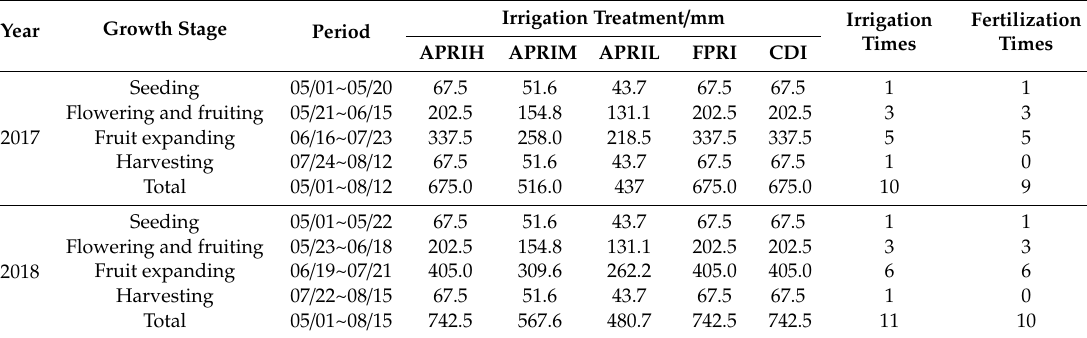
Table 2. Processing tomato irrigation schedules during the